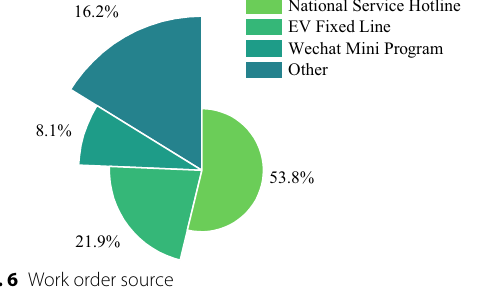
Table 1 One example of raw data